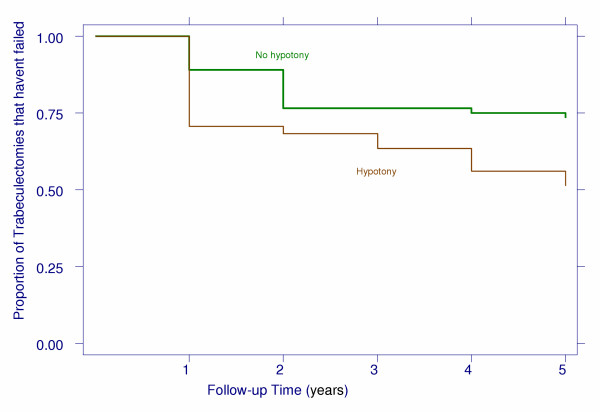
Kaplan Meier 5 year Survival of Trabeculectomies.